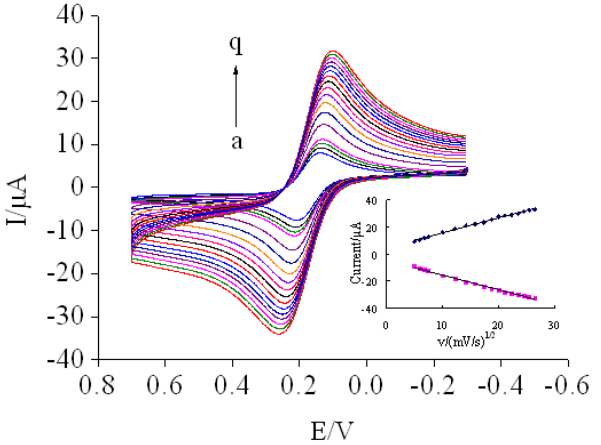
Figure 3. CVs of the modified elecrode at different scan rates (from a to q): 25, 35, 45, 55, 100, 150, 200, 250, 300, 350, 400, 450, 500, 550, 600, 650, 700 mV/s in 5 mM ] 3 − /4 − [Fe(CN) 6